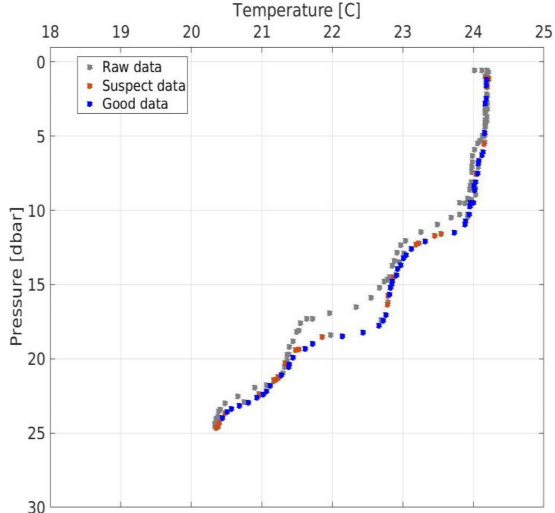
Figure 7. TD profile after applying the data quality procedure (station TD5, 1 October 2021). Both the downcast (colored points) and upcast (grey points) profiles are shown. Blue dots represent the good data (flag = 1) while orange dots correspond to data flagged as suspect data (flag =